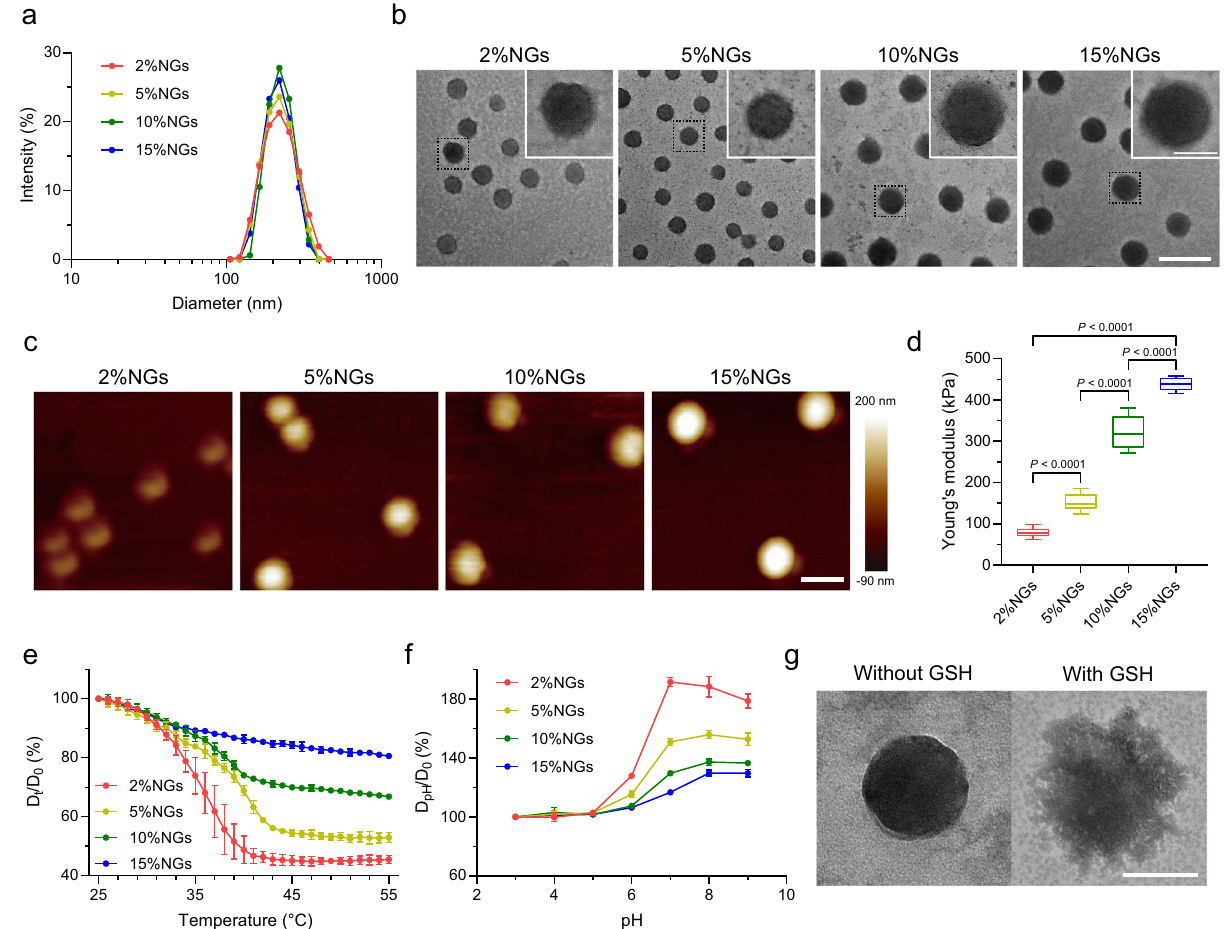
Fig.2|Characterizationofnanogelswithdistinctivestiffness.a Sizedistribution ofnanogelswithdistinctivestiffnessinPBSat37°C. b TEMimagesofnanogelswith distinctive stiffness. Scale bar=500nm in low magni fi cation and Scale bar=100 nm in high magni fi cation. c AFM images of nanogels with distinctive stiffness in liquid phase. Scale bar=200nm. d Young ’ s modulus of nanogels with distinctive stiffness in liquid phase. Box plots indicate median (middle line), 25th, 75th per- centile (box) and minimum and maximum (whiskers) ( n =15 independent